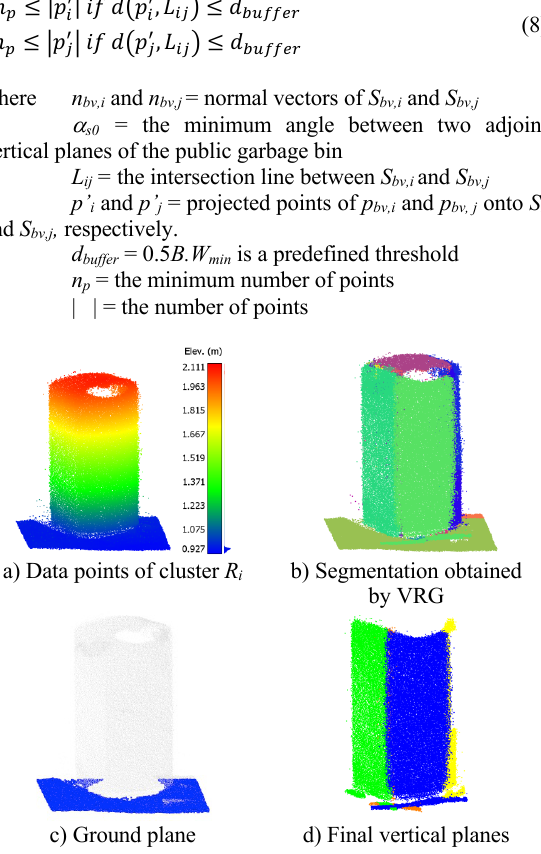
Figure 5 . Extracting vertical planes of a